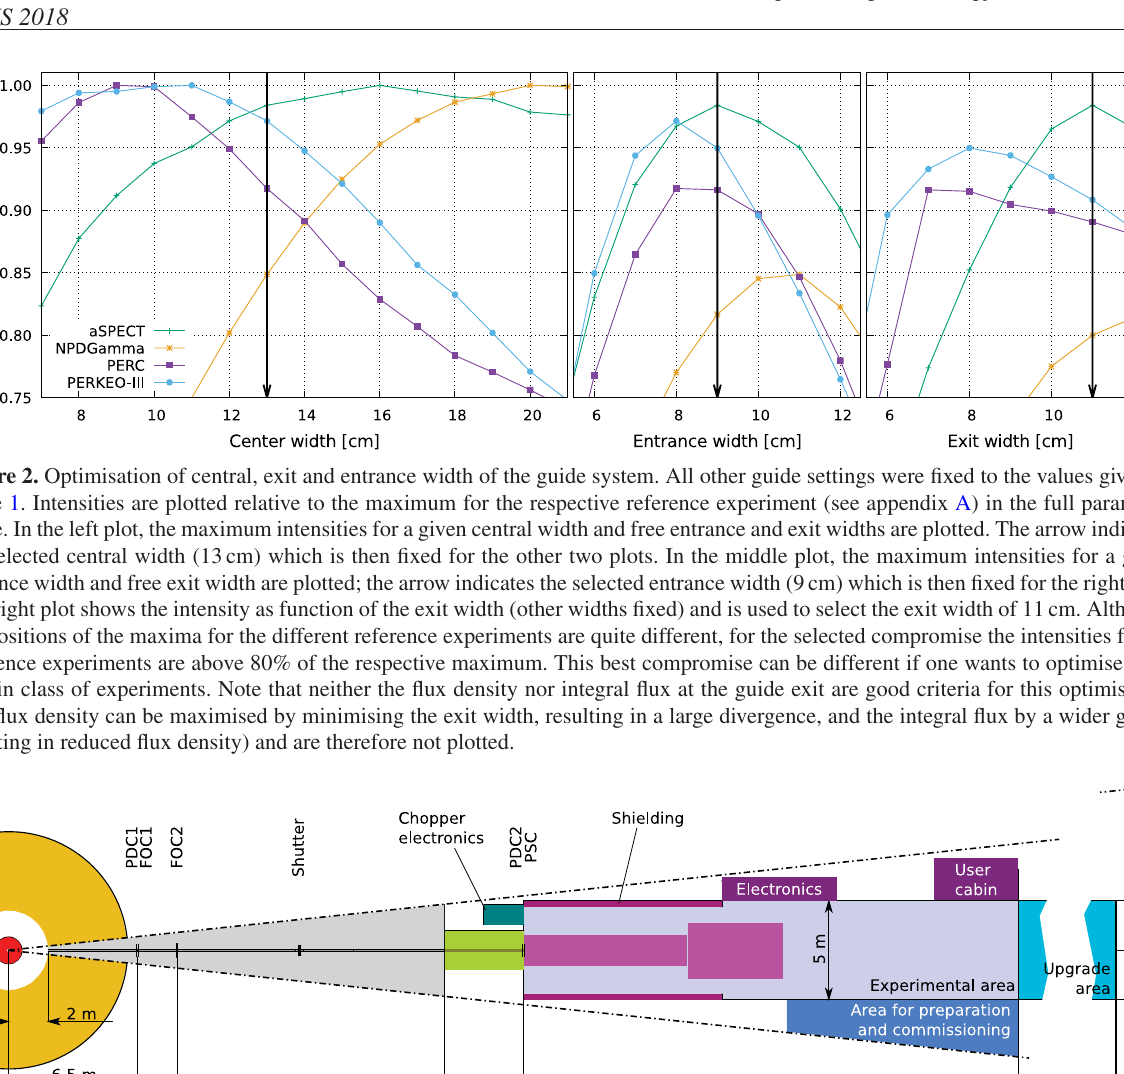
Table 2. The following chopper modes are available: Full intensity: All choppers in rest in open